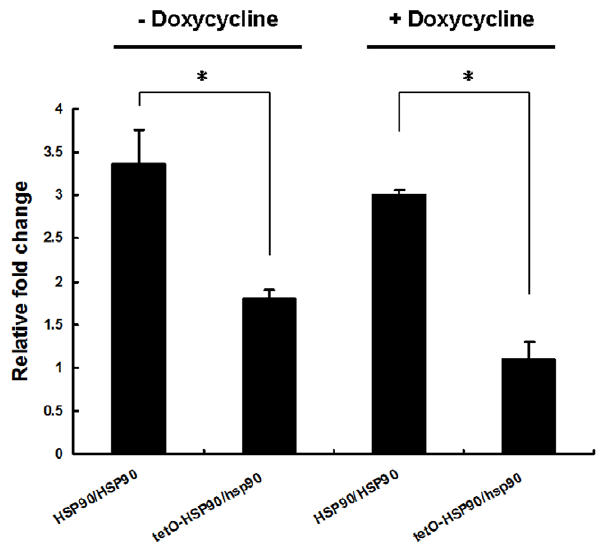
Figure 6. CaMCA1 expression after H 2 O 2 treatment. C. albicans cells were treated with 5 mM H 2 O 2 for 3 h in the absence or presence of 20 m g/ml DOX. Transcriptional level of CaMCA1 was detected by real- time RT-PCR and normalized on the basis of the 18S level. Data are shown as mean 6 SD from three independent experiments. * indicates p , 0.05 compared to the wild-type cells.